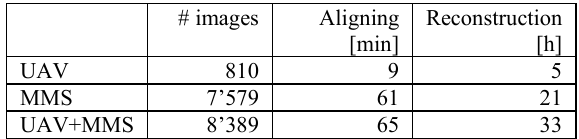
Table 4. Summary of processing